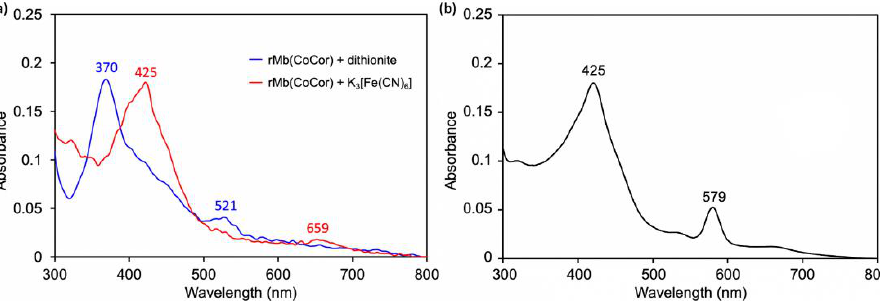
Figure 6. ( a ) UV-vis spectra of rMb(CoCor) containing dithionite (blue line) and potassium ferricyanide (red line). ( b ) UV-vis spectrum of rMb(CoCor) in the presence of 8% pyridine. Conditions: [rMb(CoCor)] = 5 µM in 100 mM potassium phosphate buffer (pH 7.0), 25 °C.